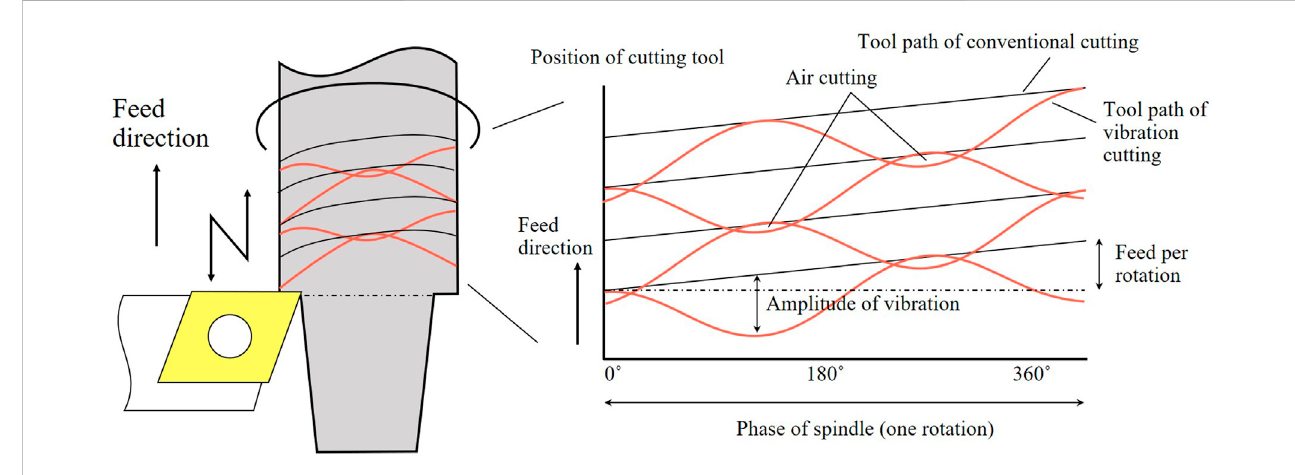
FIGURE 1 Concept of low-frequency vibration